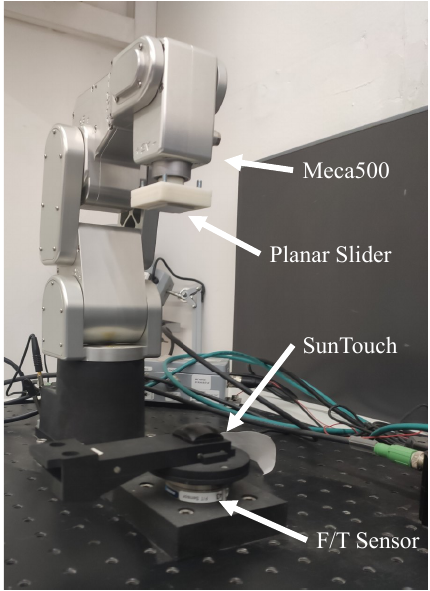
Figure 4. Setup for data